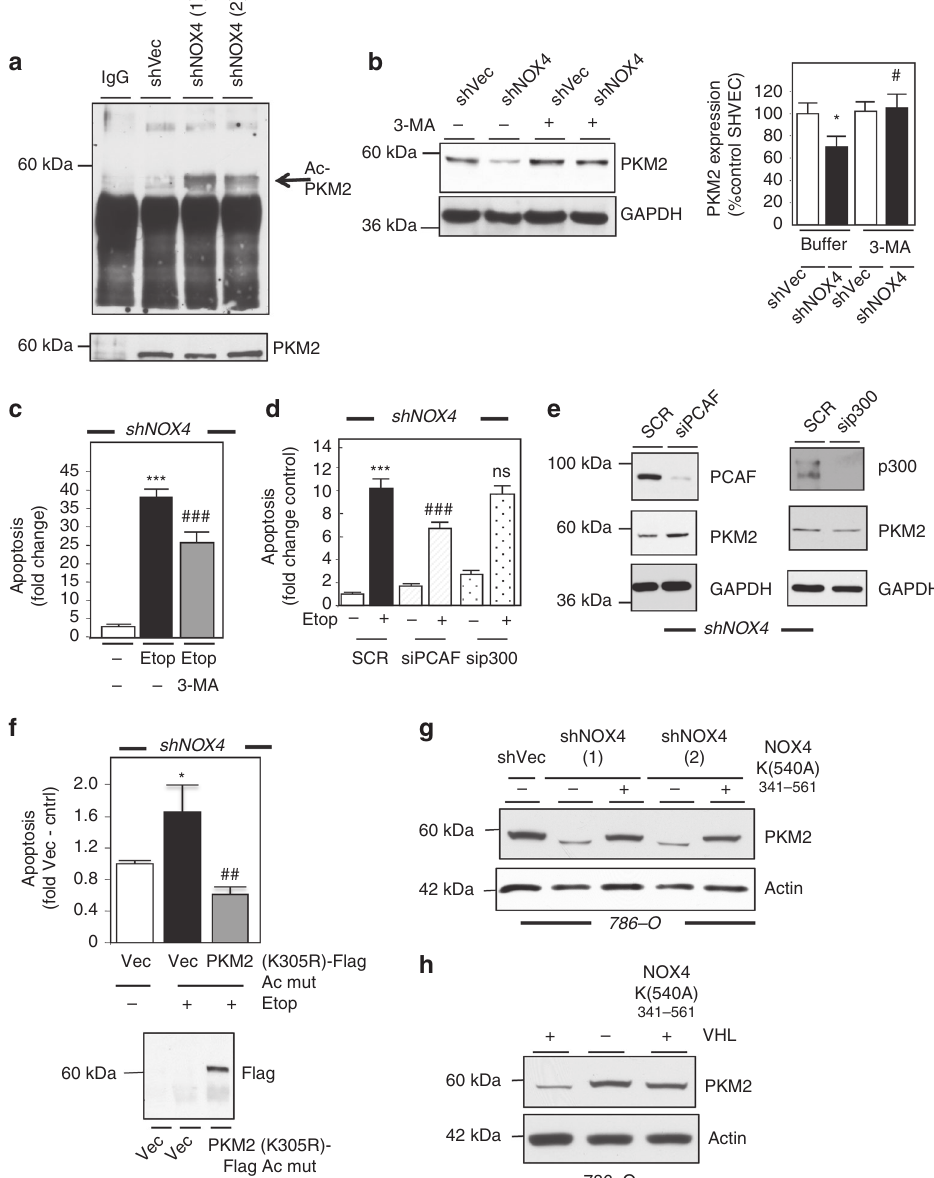
Fig. 6 NOX4 regulates PKM2 stability through PCAF-dependent acetylation and lysosomal mechanisms. a PKM2 was immunoprecipitated using PKM2 antibodies in shVec or shNOX4 786-O cells and acetylation assessed using acetylation antibodies (noted by the arrow). PKM2 pull down was validated (lower panel). b (Left panel) PKM2 expression in shVec and shNOX4 786-O cells treated (+) or not ( − ) with 5 mM 3-MA for 24 h. (Right panel) Quantitation of b where ± S.E.M. * p < 0.05 is compared to shVec without ( − ) 3-MA and # p < 0.05 compared to shNOX4 without ( − ) 3-MA. c